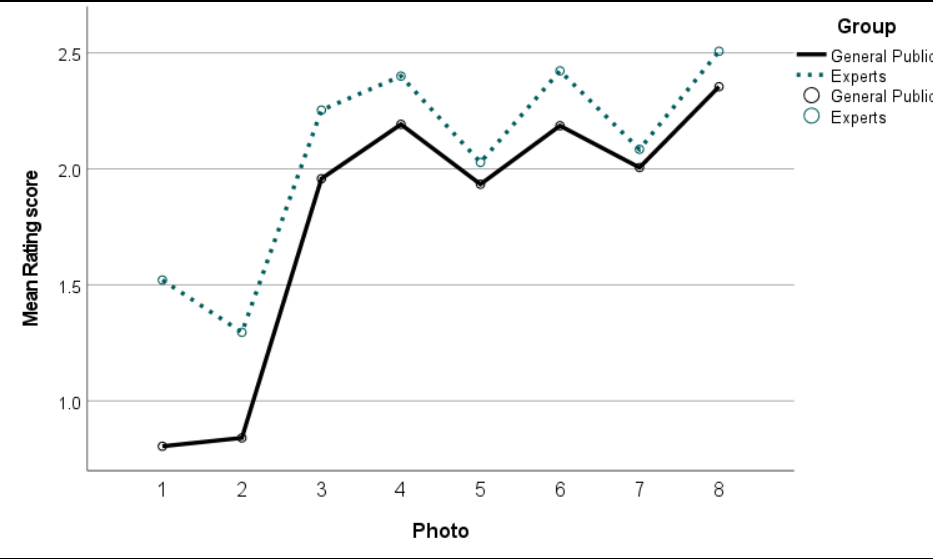
Figure 4. Mean rating scores of each context on light reflection.